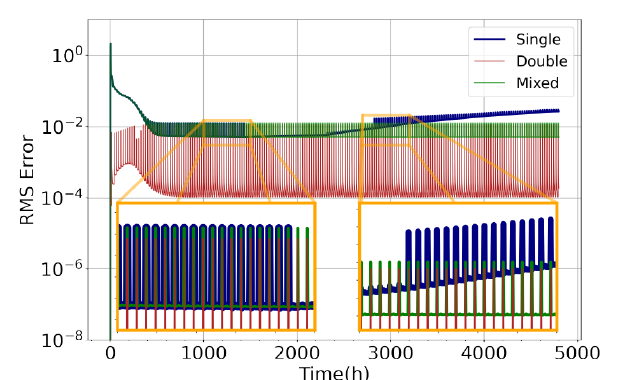
Figure 2. RMS error compared to implicit solver with RelTol = 10 − 10 (Equation (8)) against time for CBM-IV chemistry model using Rodas3 numerical solver at RelTol = 10 − 3 by out-of-the-box single precision (blue), double precision KPP (red), and the new mixed-precision implementation